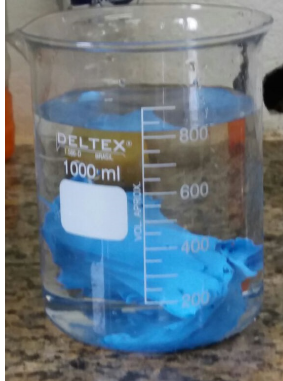
Figure 4. Collection of the RV through Archimedes’ principle.